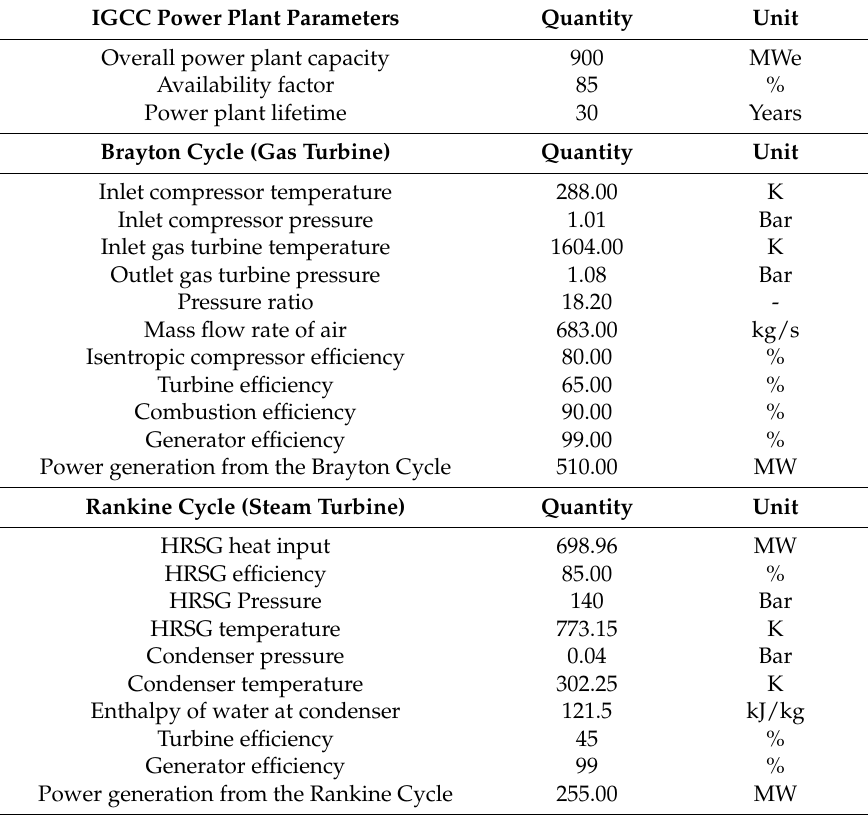
Table 8. Key assumptions on the operating parameters of the IGCC